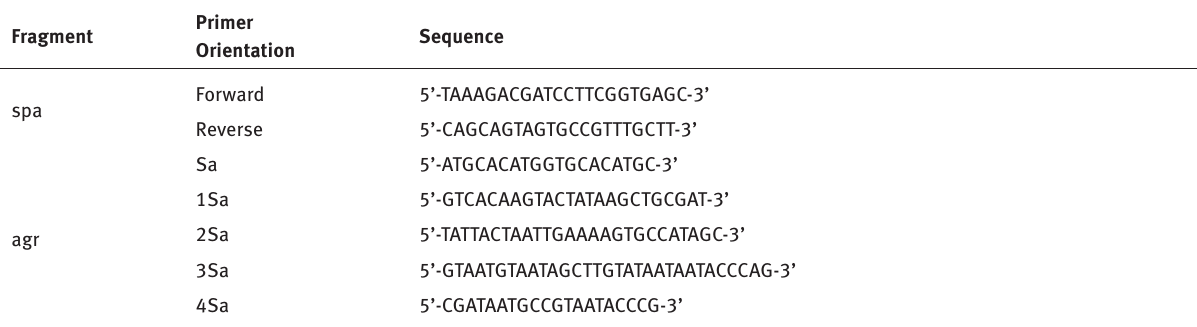
Table 1: Primers used in molecular typing experiments